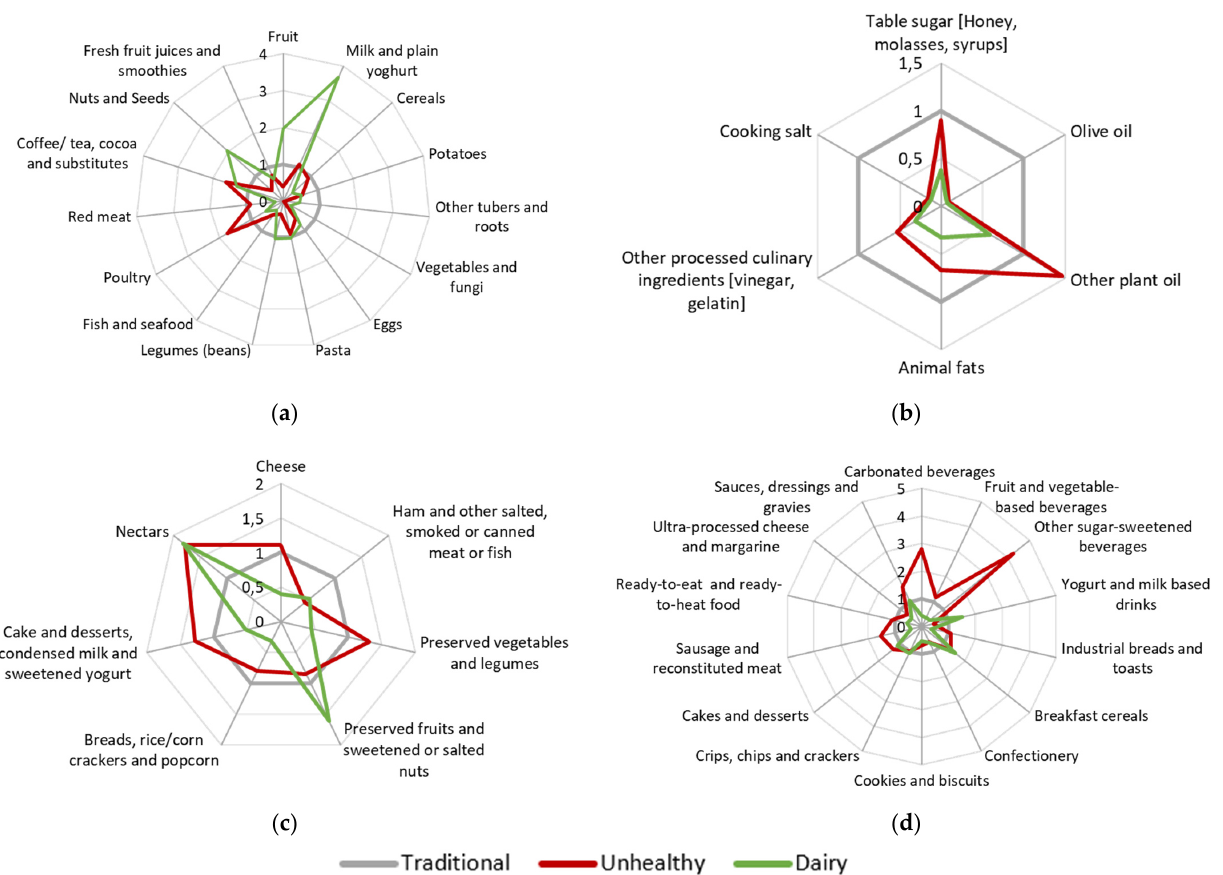
Figure 1. Odds ratio of being in the highest category of consumption of NOVA food subgroups for “Traditional”, “Un- healthy”, and “Dairy” DPs: ( a ) Unprocessed or minimally processed food; ( b ) Processed culinary ingredients; ( c ) Processed food; ( d ) Ultra-processed food. Traditional DP was used as reference.